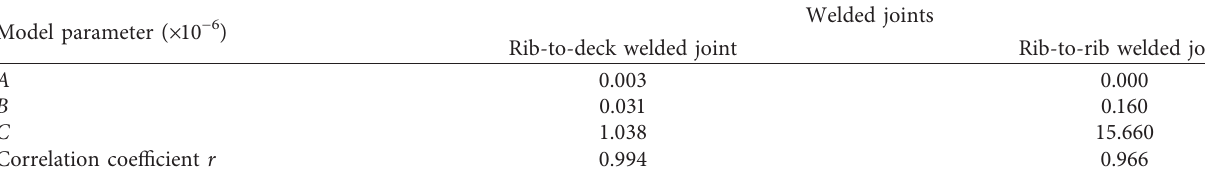
Table 1: Parameters of the correlation.